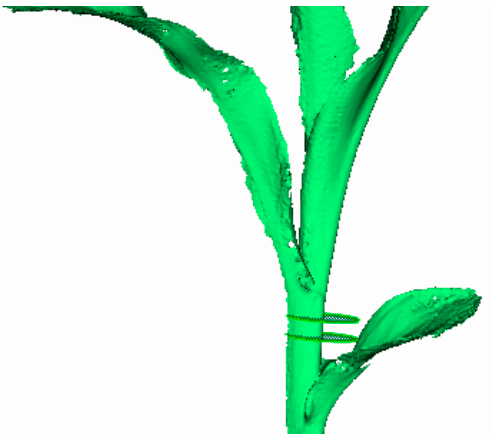
Figure 5. Calculation method for stem diameter based on the fitting cylinder.